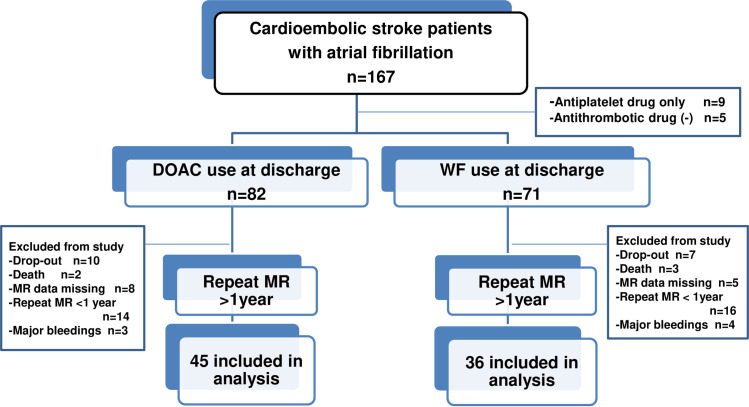
Flow diagram of the present study.Patients who had been prescribed anticoagulants at discharge and were able to visit our hospital as outpatients were included in the present study.